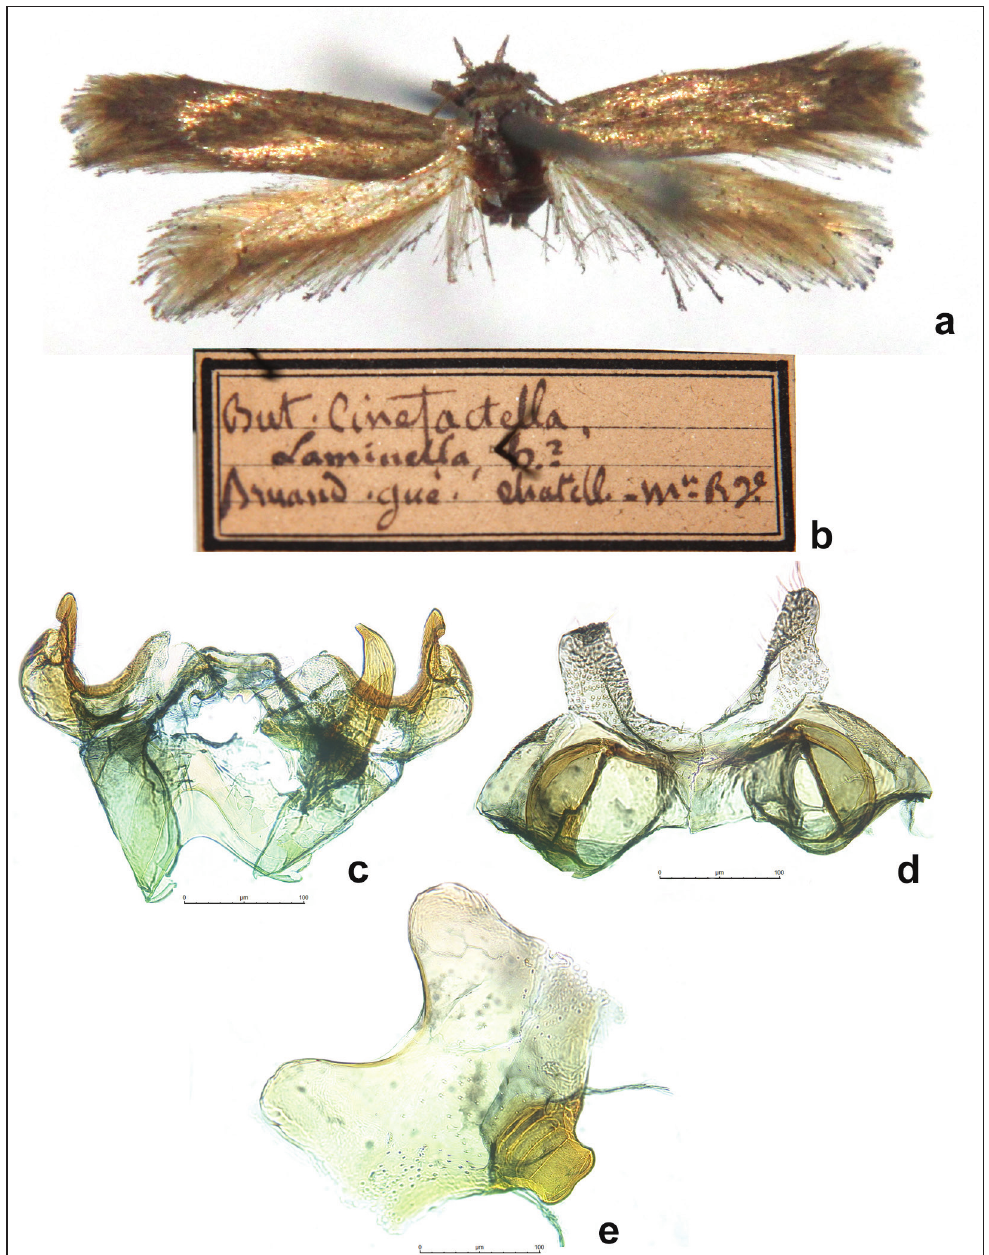
Figure 5. Holotype of Butalis cinefactella (Bruand, 1851), male. a – habitus, wingspan 12 mm; b – original label; c – genitalia, valvae, phallus, tegument, and gnathos; d – genitalia, tergum 8; e – genitalia, sternum